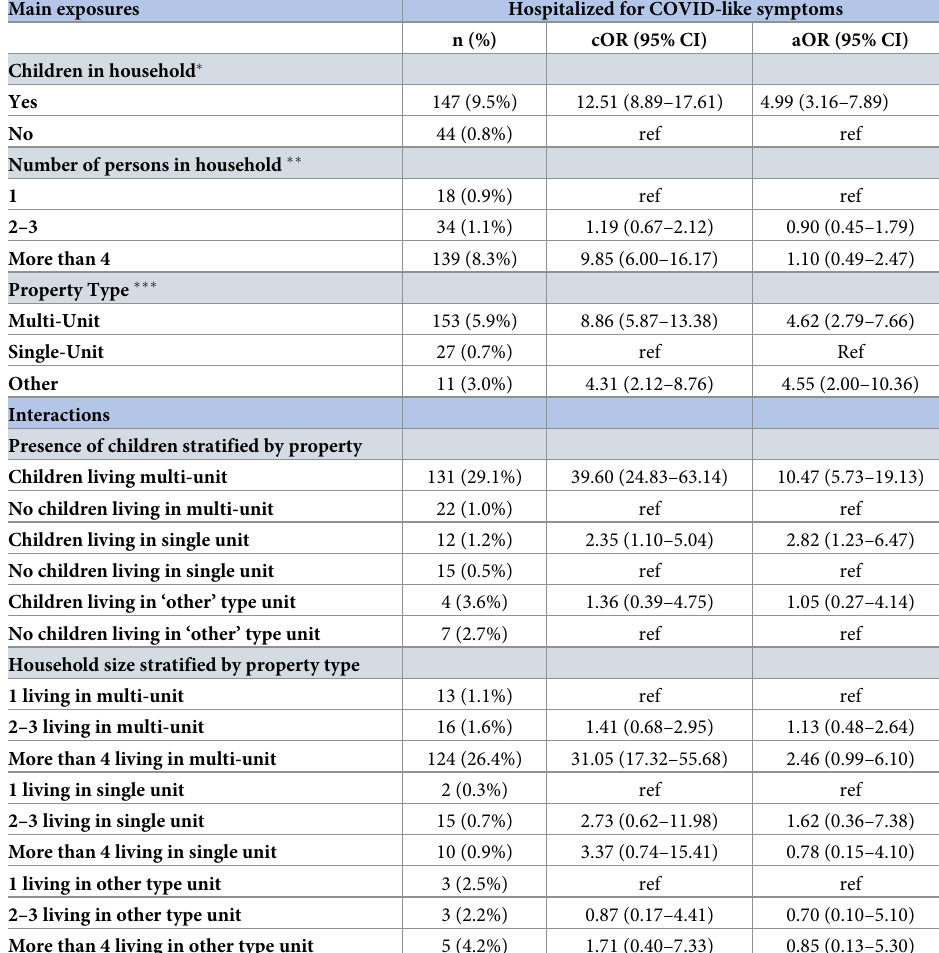
Table 2. Main effects of presence of children, number of persons in households and property type on hospitaliza- tion for COVID-like symptoms (N = 6831), April 2020. Main